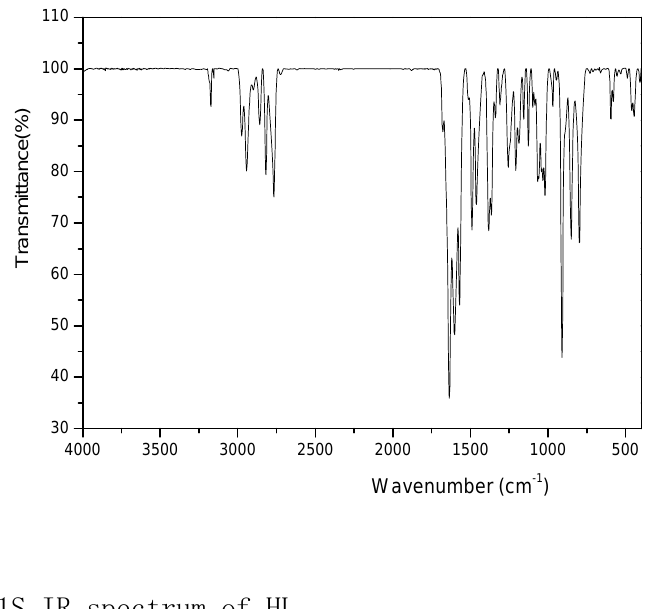
Fig.1S IR spectrum of HL.